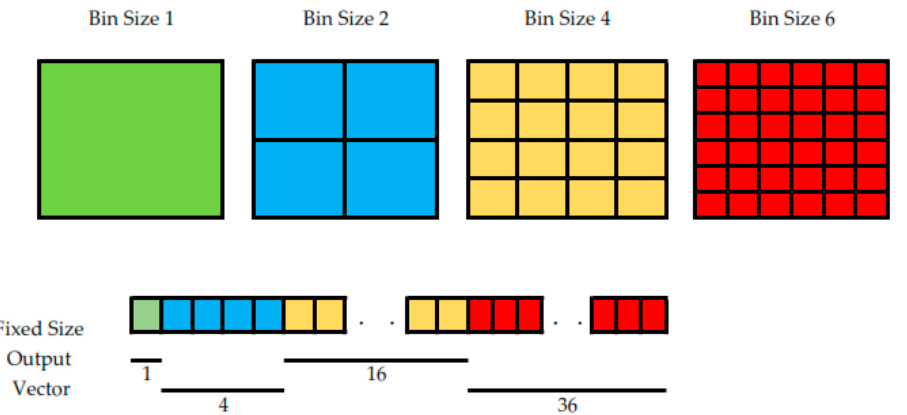
Figure 5. Multilevel spatial bin, with the example of bin-size-6 resultant feature maps segmented into 6 × 6 subsets.